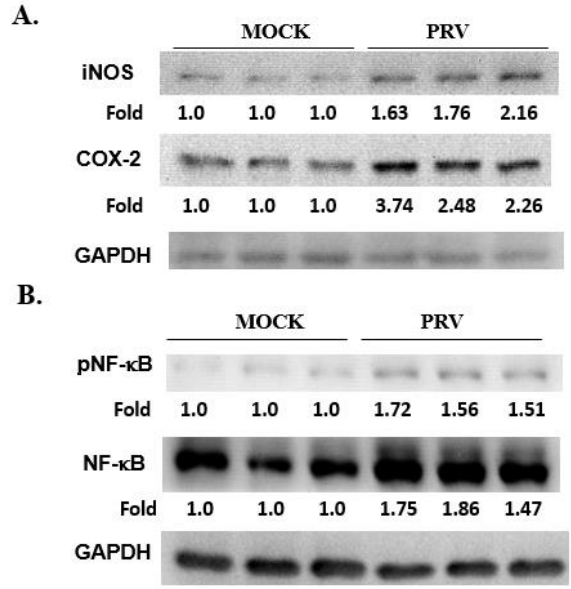
Figure 6. The levels of iNOS, COX-2 and NF- κ B expressed in the brains of PRV-infected mice. The expression levels of iNOS, COX-2 and NF- κ B in the brains of mice infected with 10 5 PFU PRV for 48